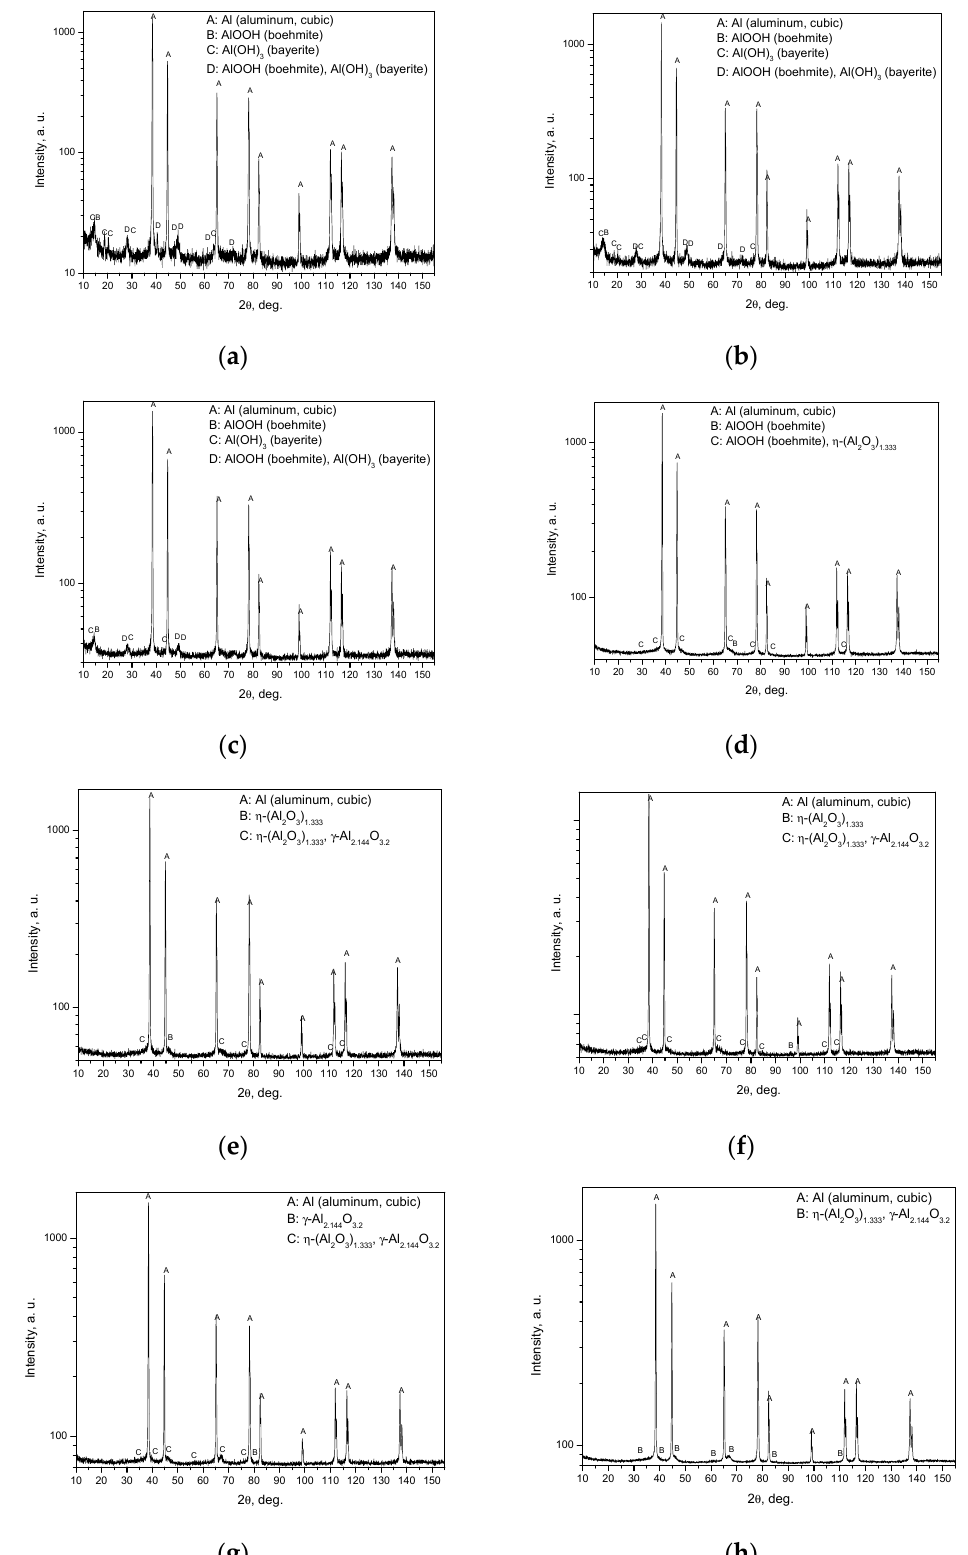
Figure 7. Results of X-ray diffraction analysis for different samples: ( a ) sample after drying at 120 °C; ( b ) sample after thermal treatment at 200 °C; ( c ) sample after thermal treatment at 300 °C; ( d ) sample after thermal treatment at 400 °C; ( e ) sample after thermal treatment at 450 °C; ( f ) sample after thermal treatment at 500 °C; ( g ) sample after thermal treatment at 550 °C; ( h ) sample after thermal treatment at 600 °C.